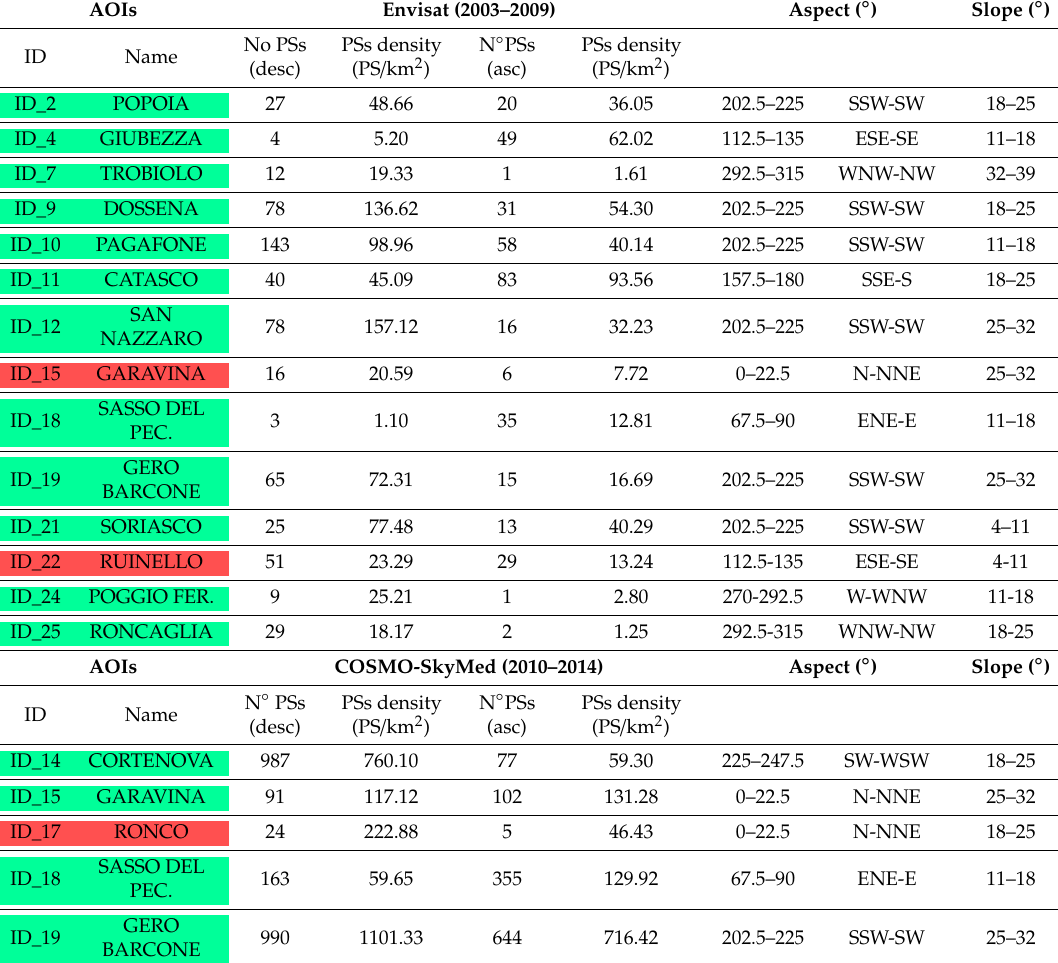
Table 4. Comparison of the A-DInSAR results for the AOIs analyzed with both ascending and descending datasets. Green color indicates the cases in which the descending geometry retrieves a larger number of PSs on slopes with aspect towards west, and cases in which the ascending geometry retrieves a larger number of PSs on slopes with aspect towards east. Red color indicates the cases where the comparison of results doesn’t confirm this general trend about SAR acquisition geometries. AOIs Envisat (2003–2009) Slope ( ◦